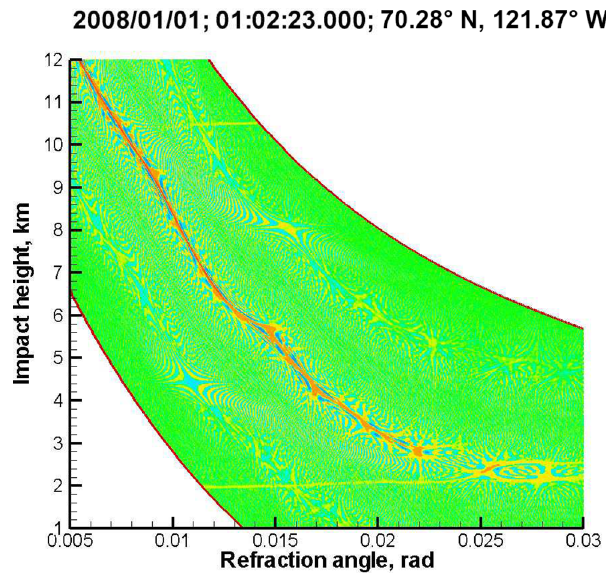
Figure 2. Reflection over ice and snow. The branch of bending an- gle profile corresponding to the reflection looks like a nearly hori- zontal line at the impact height of about 2km. Cf. Fig. 1.